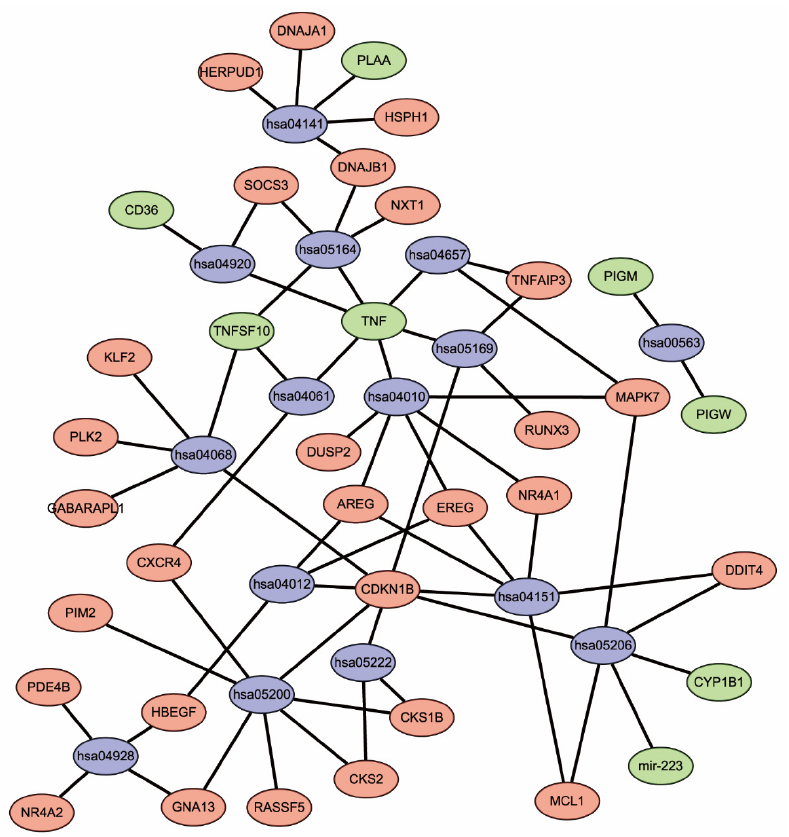
Figure 4. Network diagram of enriched pathways. Blue represents pathways, red represents upregulated DEGs, and green represents downregulated DEGs.